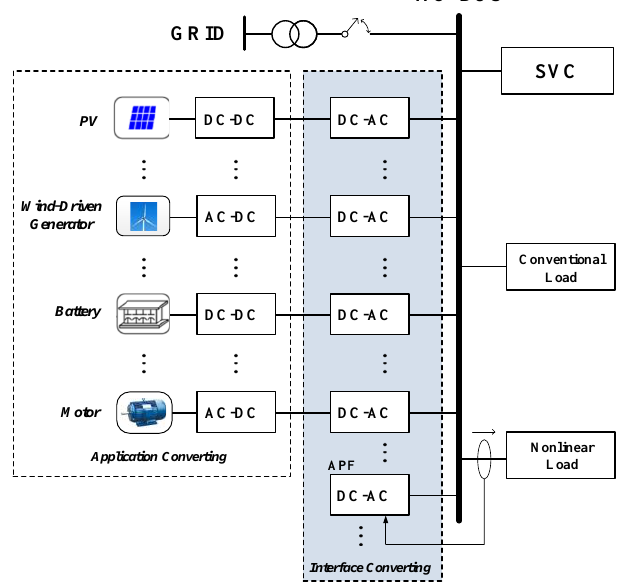
Figure 1. Fundamental configuration of a multi-parallel grid-connected VSI system.